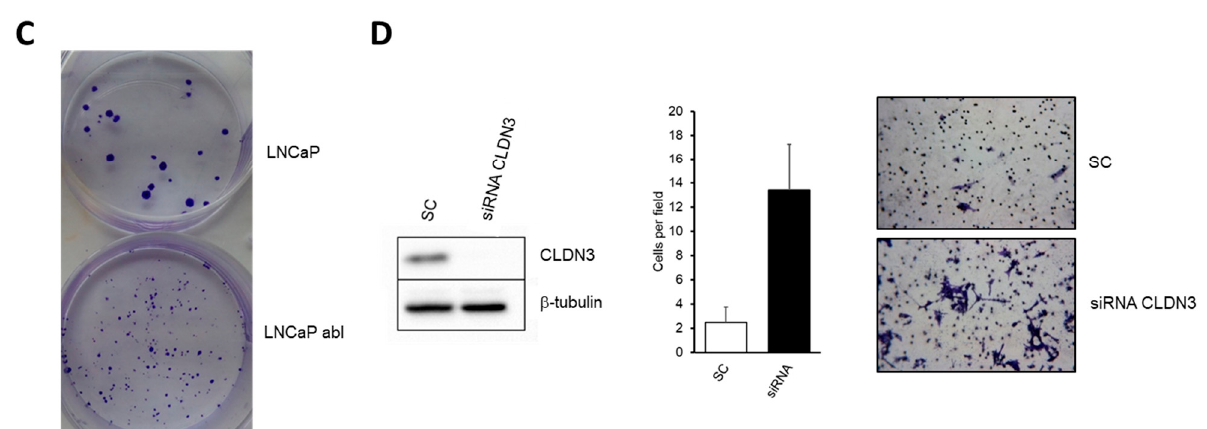
Figure 5. Loss of CLDN3 is associated with increased cellular invasion in prostate cancer cell lines. ( A ) CLDN3 expression in LNCap and LNCaP abl cell lines determined by Western Blot and confocal analysis. Red staining indicates positivity for CLDN3 and nuclei were labelled with DAPI (blue). Micro-photographs were taken at 40X magnification. Scale bar 25 µ M ( B ) Comparison of cellular invasion capacity of LNCaP and LNCaP abl cell lines. ( C ) Colony formation assay of LNCaP and LNCaP abl cell lines. ( D ) Effect of CLDN3 siRNA on cellular invasion of LNCaP cells. Loss of CLDN3 is associated with increased invasion capacity of LNCaP cells in a similar way than LNCaP abl compared with LNCaP cells. Micro-photographs were taken at 10X magnification.